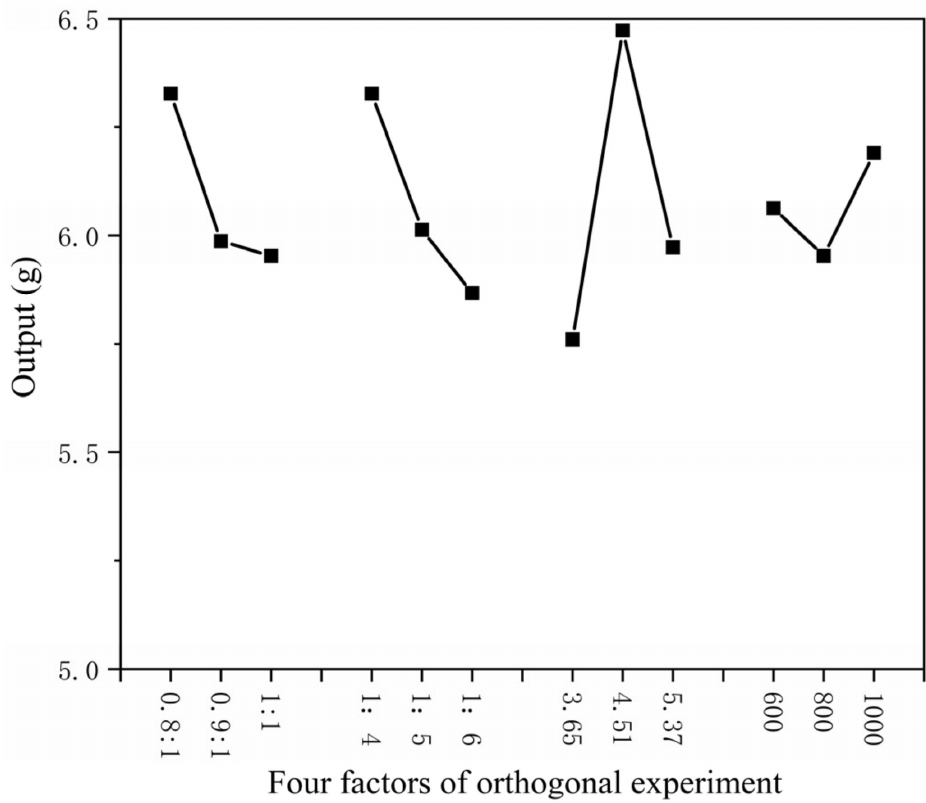
Figure 1. Relationship between four factors of orthogonal experiment and yield.